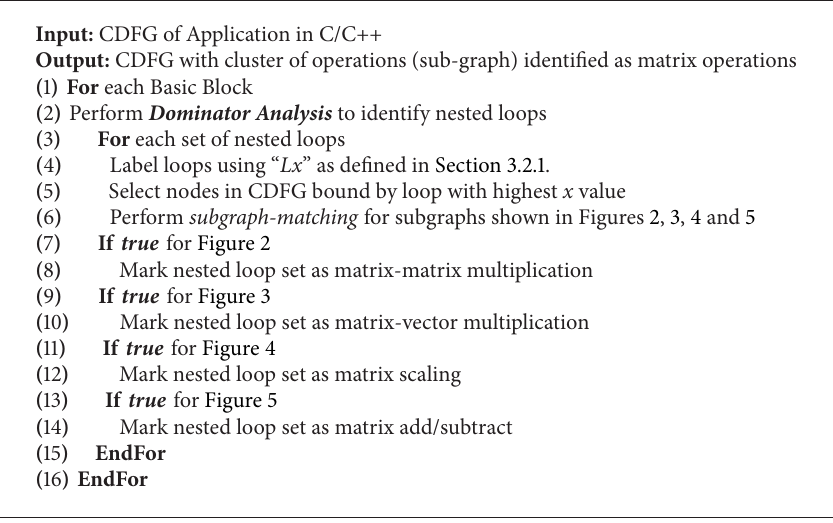
Algorithm 5: Identification of matrix operations in LLVM IR.